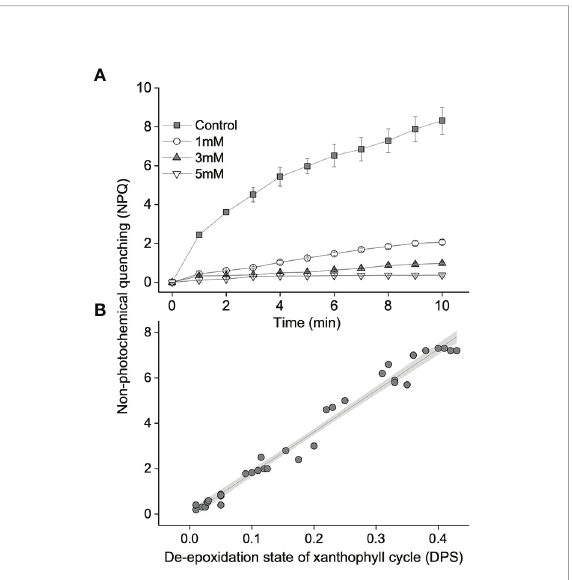
FIGURE 3 (A) Values of non-photochemical quenching (NPQ) in blades treated with different concentrations of dithiothreitol (DTT) during a 10-min high light exposure (1,200 m mol photons m – 2 s – 1 ). Gray squares, white circles, and gray or white tringles represent control (0 mM DTT), 1, 3, and 5 mM DTT, respectively. (B) Relationship between NPQ and the de-epoxidation state of the xanthophyll cycle (DPS). The solid line and gray shadow represent the fi t of data to a linear model ( p < 0.01 and R 2 = 0.99; n = 33) and the 95% con fi dence interval, respectively. The data shown in A represent the mean ± SD ( n =